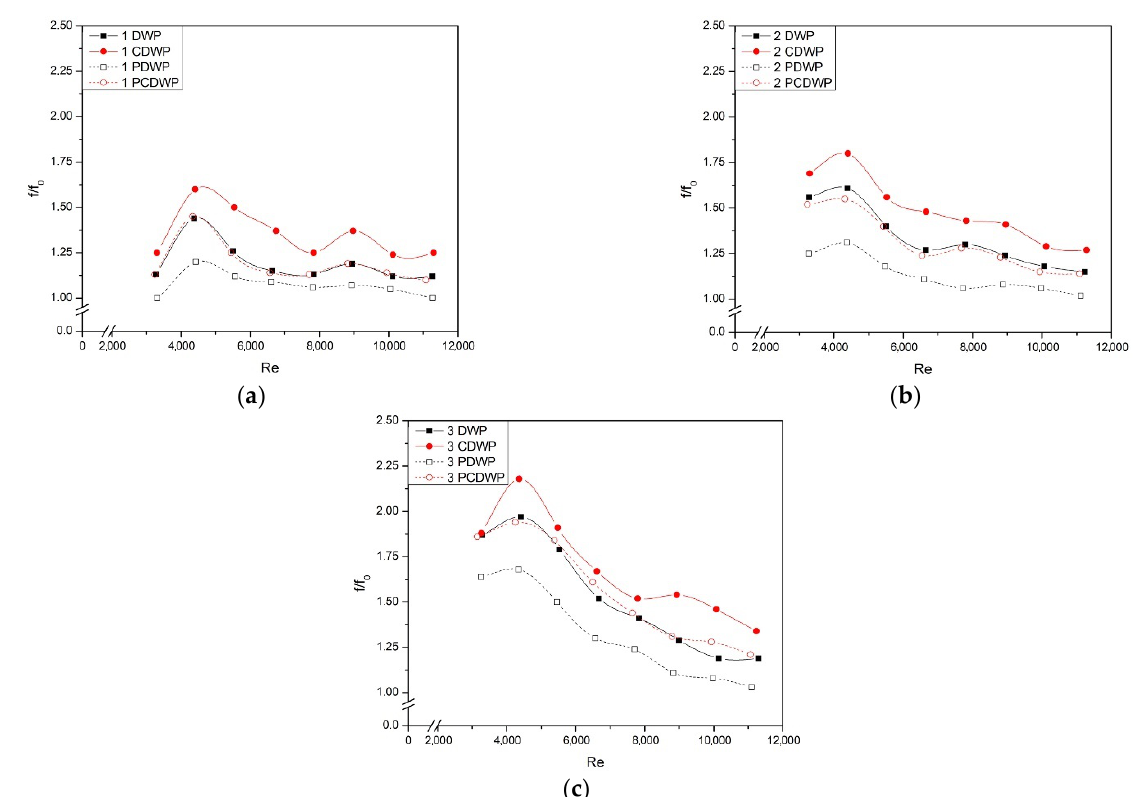
Figure 5. f / f 0 for the use of VGs with/without holes on the Reynolds number and the number of pairs of VG. ( a ) One pair of VG, ( b ) Two pairs of VG, and ( c ) Three pairs of VG.